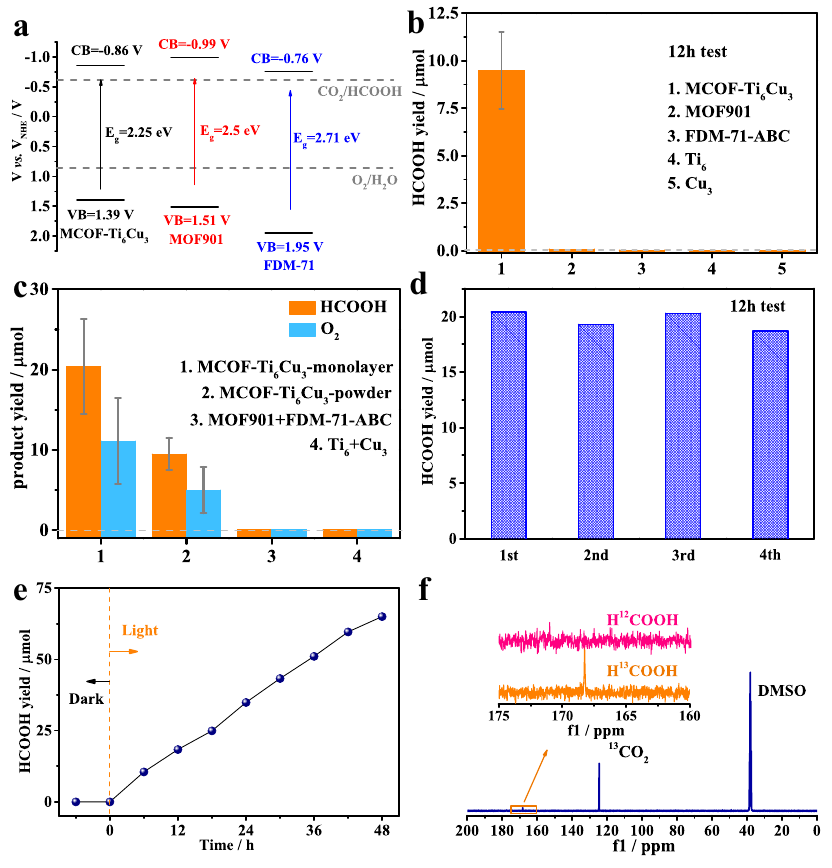
Fig. 3 | The CO 2 RR performance for various photocatalysts. a Band structure diagram of MOF901, FDM-71-ABC and MCOF-Ti 6 Cu 3 . Photocatalysisperformances: b The comparison of HCOOH yields for different samples. c The photocatalytic products yields for samples with different morphology and physical